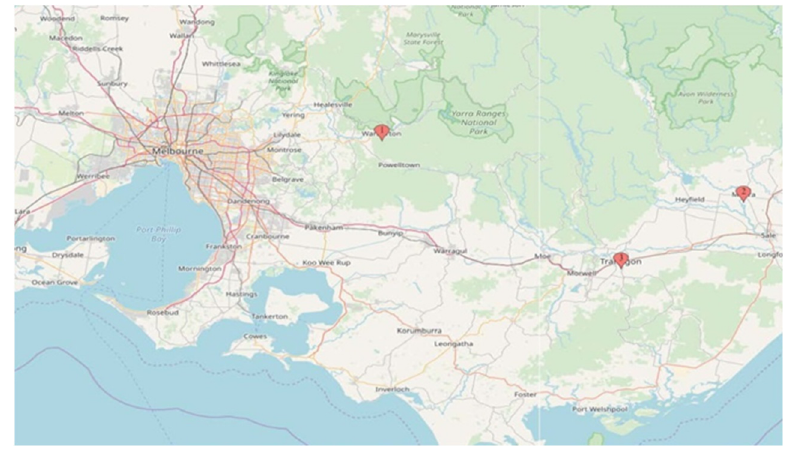
Figure 1. Study locations: Victoria, Australia.